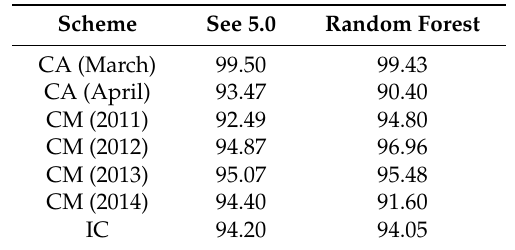
Table 4. Accuracy assessment results of See 5.0 and random forest by scheme through 10-fold cross-validation. The overall accuracy in percentage averaged for 10 folds is provided.